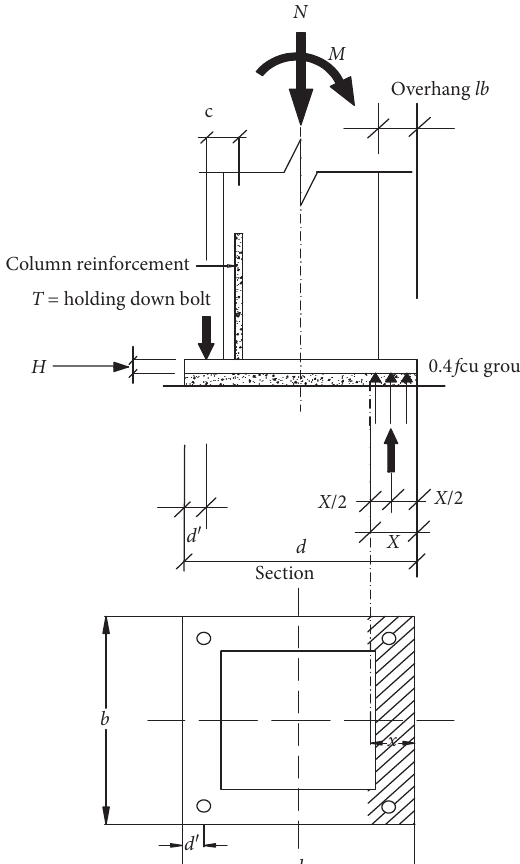
Figure 3: Force distribution in base plate of precast column.